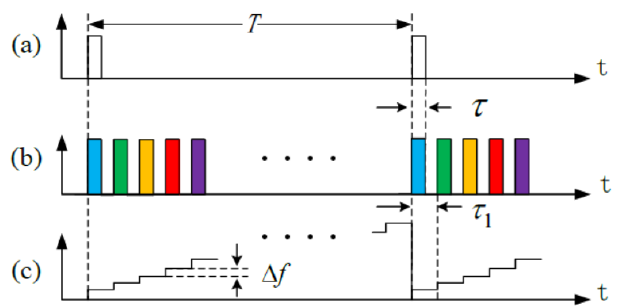
Figure 10. The pulse sequences of ( a ) conventional Φ -OTDR and ( b ) TSMF. ( c ) The laser frequency of probe pulses in TSMF. Reproduced with permission from our previous paper [19], published by Optical Society of America, 2015.